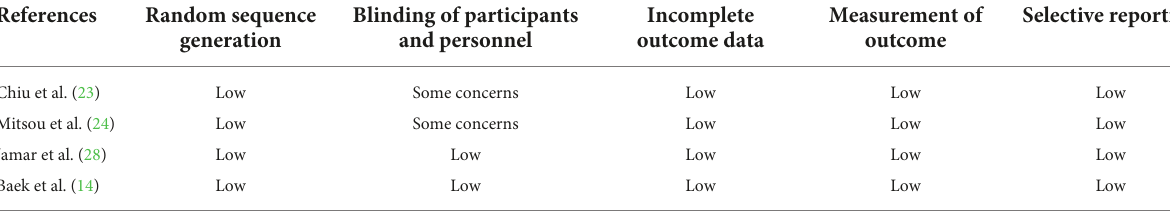
TABLE 2 Risk of bias assessment of randomized controlled trials of the effect of fruit intake on FC.